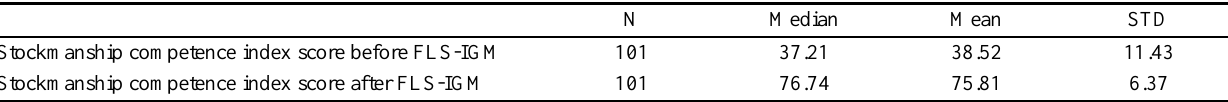
Table 1. Stockmanship competence index score of farmers before and after undergoing FLS-IGM